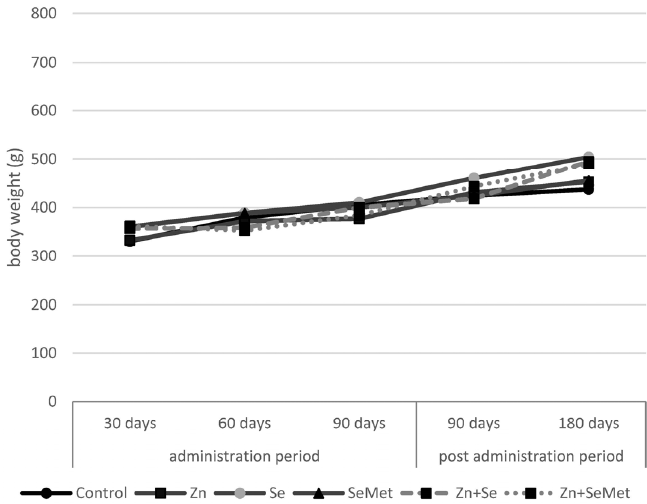
Figure 1. Whole body weight of rats following zinc gluconate (Zn), sodium selenite (Se) and selenomethionine (SeMet) administration given jointly or separately for 30, 60 and 90 days and then after 90 and 180 days post administration.